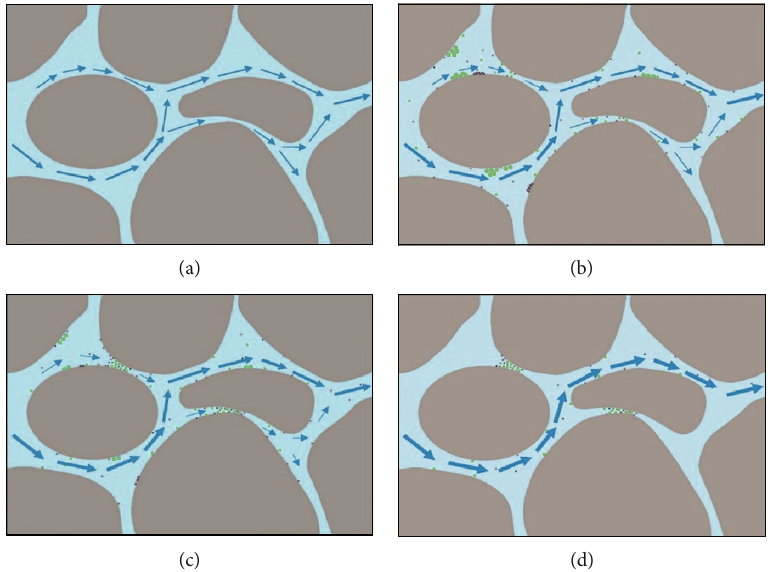
Figure 10: Illustration of the pore structure at di ff erent stages: (a) initial state, (b) early stage, (c) middle stage, and (d) late